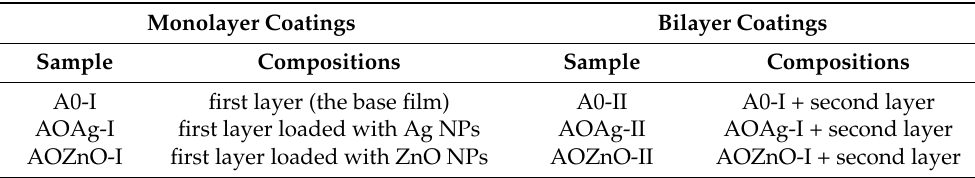
Table 1. Composition of the studied coatings deposited on three different metallic supports (brass, copper, mild